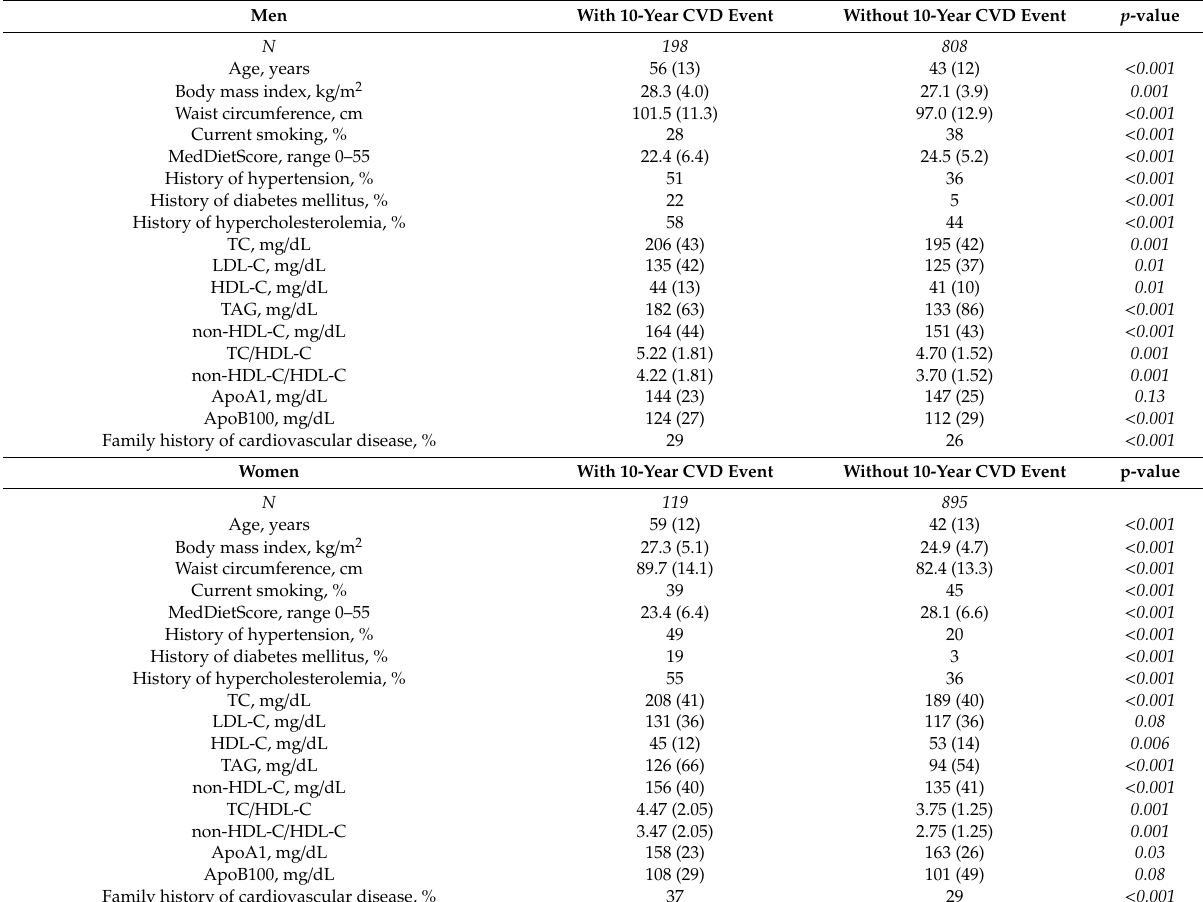
Table 1. Baseline sociodemographic, clinical, biochemical, and lifestyle factors of men and women from the ATTICA study, according to 10-year cardiovascular disease incidence ( n =